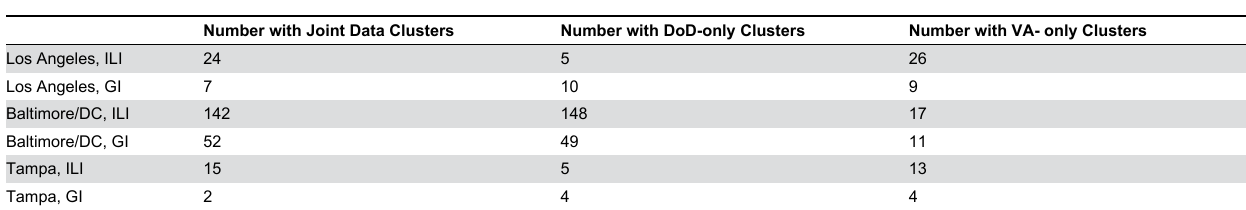
Table 4. Number of alerts using scan statistics to find significant case clusters (p<0.001) * by metropolitan area and syndrome group combining Department of Defense (DoD) and Veterans Affairs (VA) datasets from October 1, 2006 -